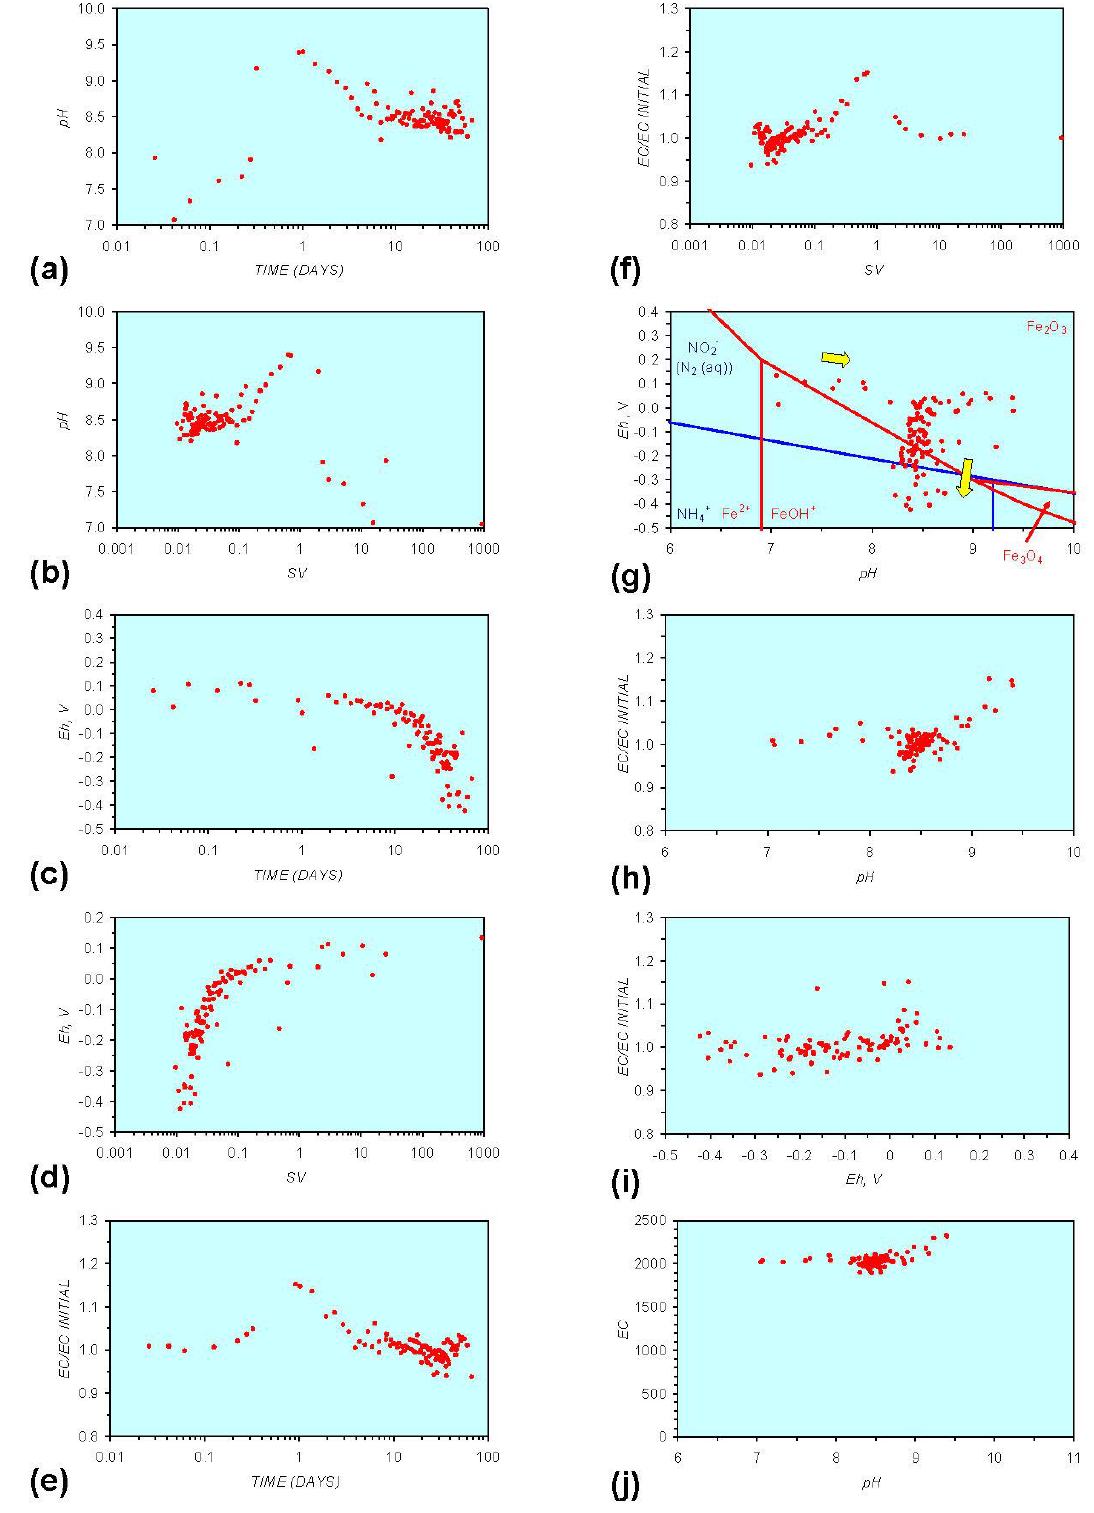
Figure A14. MR14: Ca-montmorillonite + n-Fe 0 + n-Cu 0 , saline water. (a) pH vs. Time; (b) pH vs. SV; (c) Eh vs. time; (d) Eh vs. SV; (e) EC/EC Initial vs. time; (f) EC/EC Initial vs. SV; (g) Eh vs. p(H) The redox trajectory ends in an SRE with a stable pH and decreasing Eh with time; (h) pH vs. EC/EC Initial; (i) Eh vs. EC/EC Initial; (j) pH vs. E(C) Arrows indicate decreasing SV and increasing